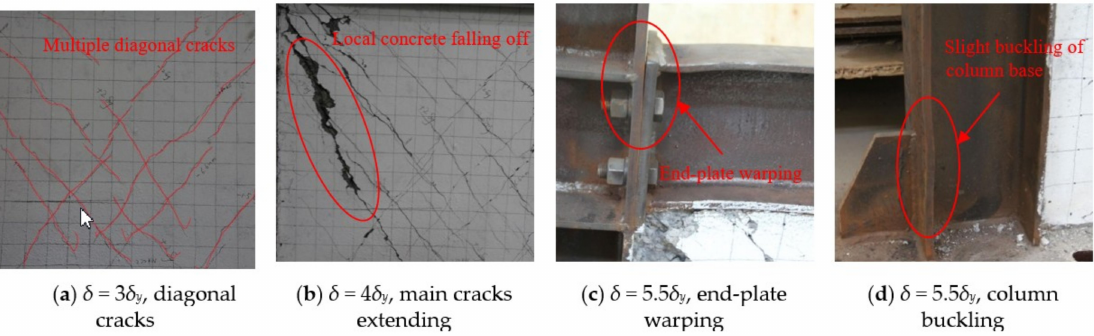
Figure 6. Local failure of